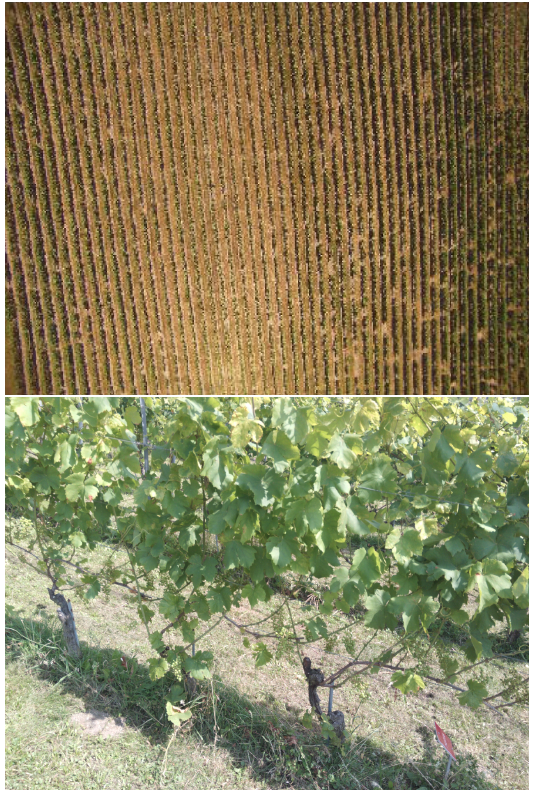
Figure 1: Comparison of a drone view (Kerkech et al., 2020) and a ground view of vineyards. One can notice the fruits under the plant on the terrestrial image.